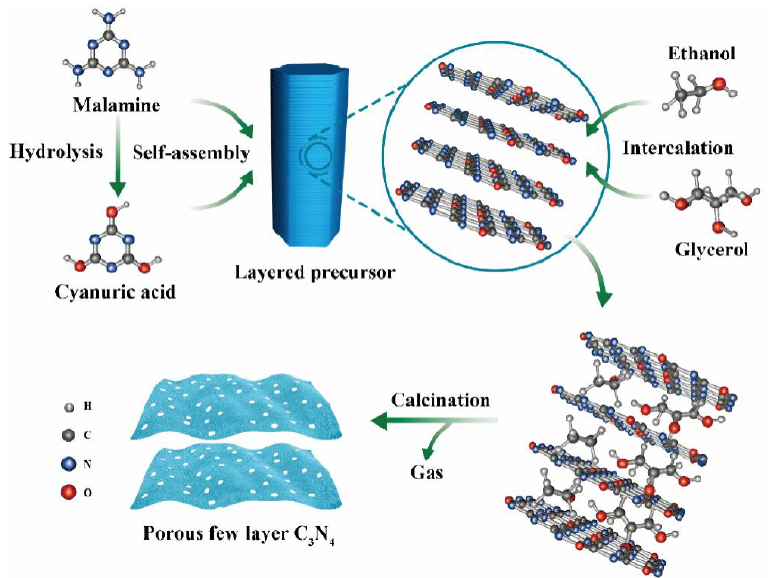
Figure 5. Schematic illustration for the self − assembled method to prepare few-layer porous structures of g − C 3 N 4 [75]. Copyright 2019, American Chemical Society.